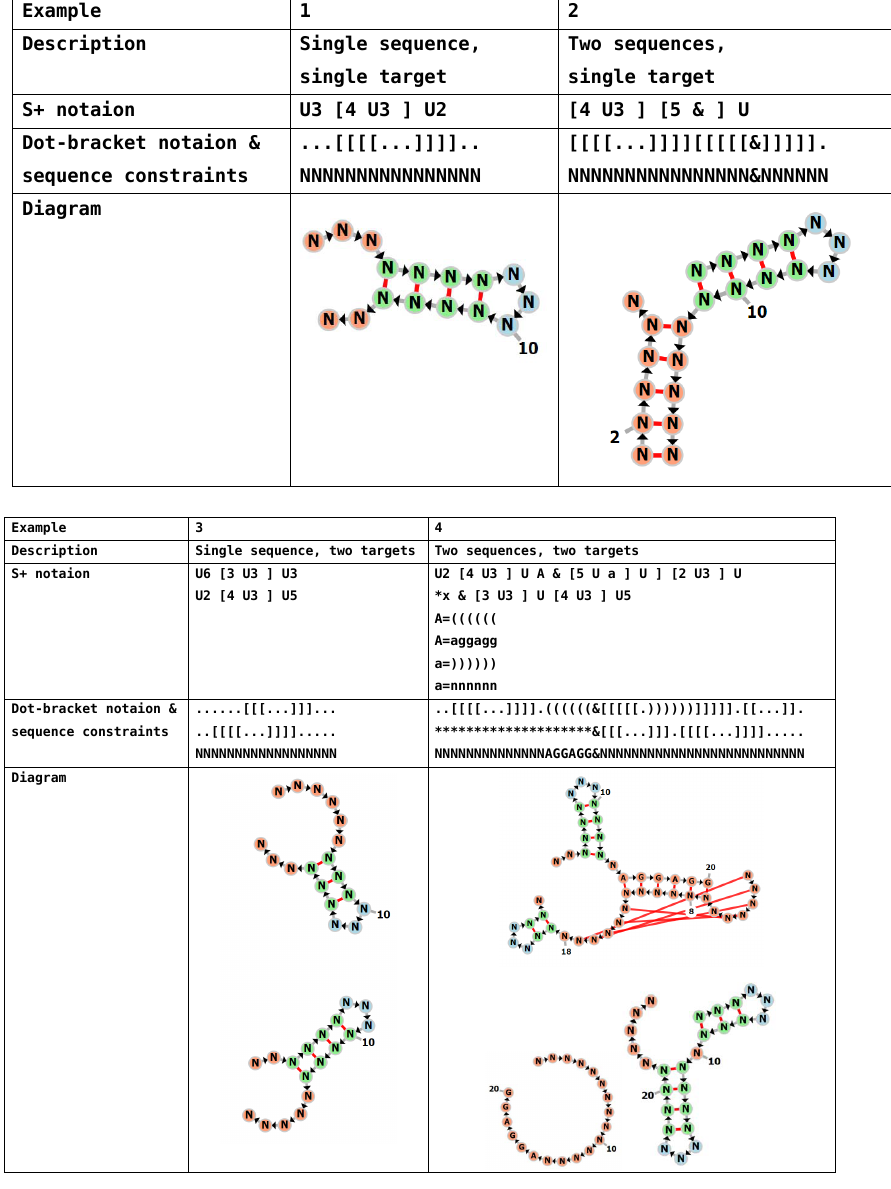
Figure 3. Toy examples of secondary structures specified in S+ notation. (Example 1 ) A single RNA. (Example 2 ) A complex of two RNAs. (Example 3 ) A single RNA with meta-stable structures. (Example 4 ) An RNA–RNA switch with sequence/structure